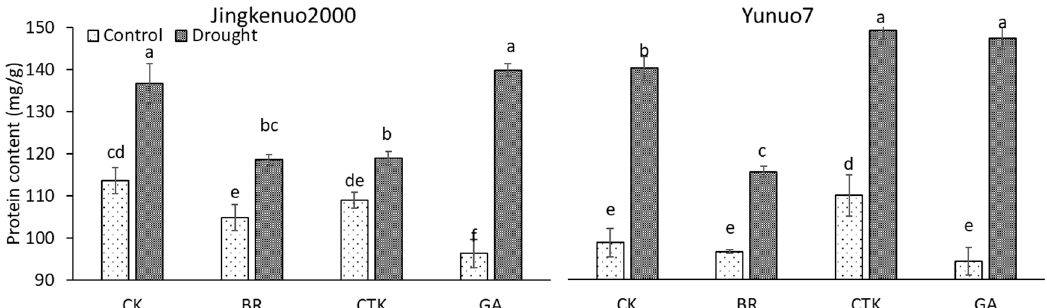
Figure 3. The grain protein content with exogenous hormones under control and drought conditions in waxy maize. CK, water; CTK, cytokinin; BR, brassinolide; GA, gibberellic acid. Bars mean SE (n = 3). Different letters above the bars in each hybrid are significantly different at 5% probability level.